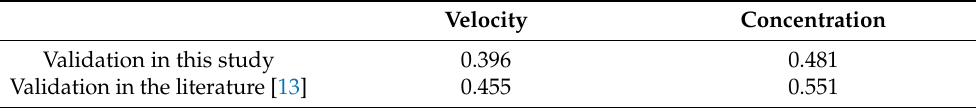
Table 6. The RMSE discrepancy between the measurement and the CFD modeling for the velocity and particle concentration. Velocity Concentration Validation in this study 0.396 0.481 Validation in the literature [13] 0.455